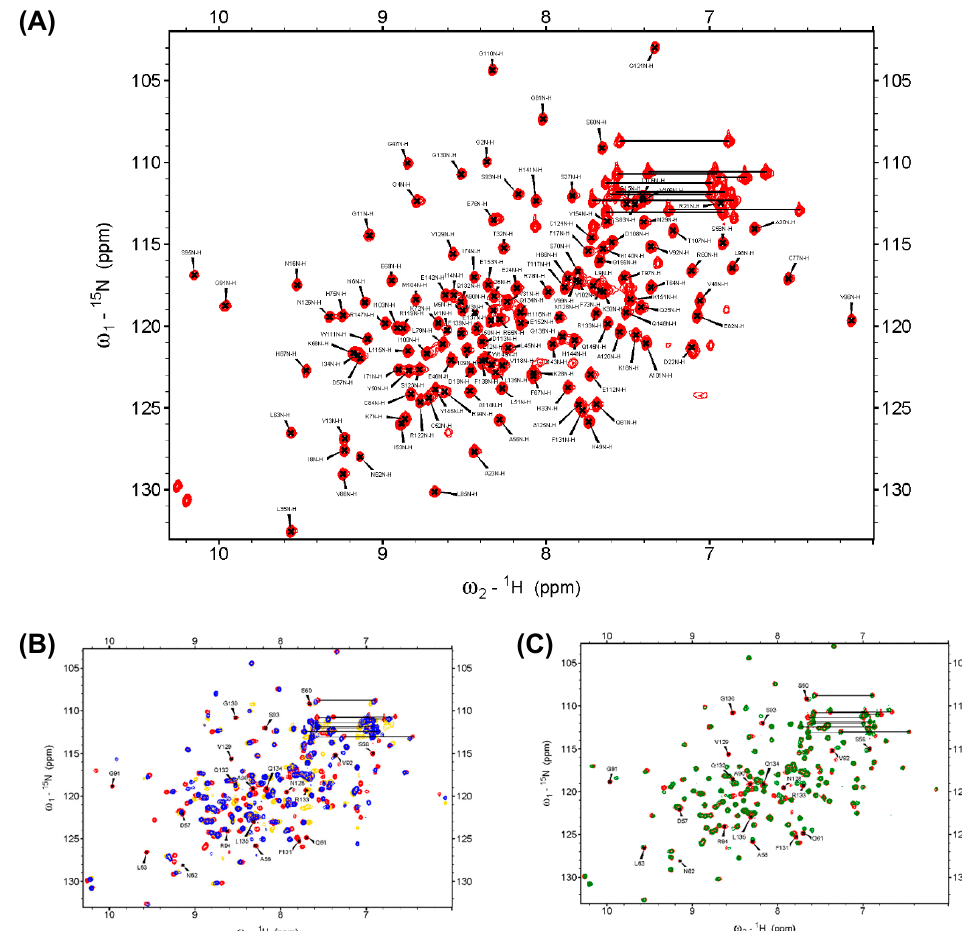
Figure 2. The backbone assignment of DUSP22_WT and the superimposed 1 H-, 15 N-HSQC spectra of the WT, S93N, N128A, and D57N. ( A ) The backbone amide resonance of residues in the WT is assigned on the 1 H-, 15 N-HSQC spectrum. It exhibited 139 backbone amide resonances of 150 expected resonances (5 prolines removed) in DUSP22 and showed 93% completion. ( B ) The 1 H-, 15 N-HSQC spectrum of the WT (red) was superimposed with the spectra of S93N (yellow) and N128A (blue). The spectra indicated that the mutants critically perturbed the solution structures and shifted several residues. ( C ) The 1 H-, 15 N-HSQC spectrum of the WT (red) was superimposed with the spectra of D57N (green), which revealed the region perturbed by the DPN–triloop interaction. The labeled amino acids on the spectra were the residues in the D-loop, P-loop, and N-loop of the